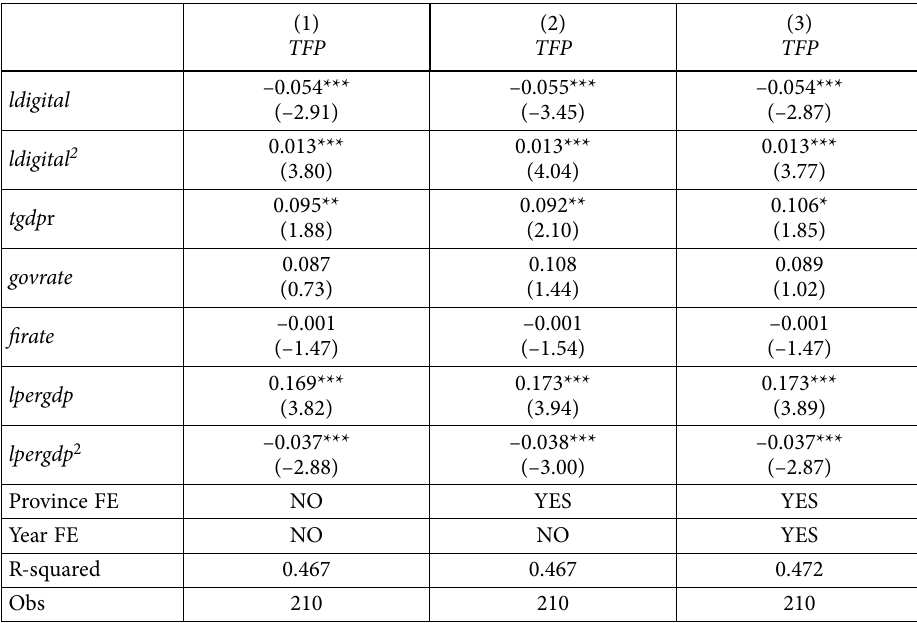
Table 4. Benchmark model